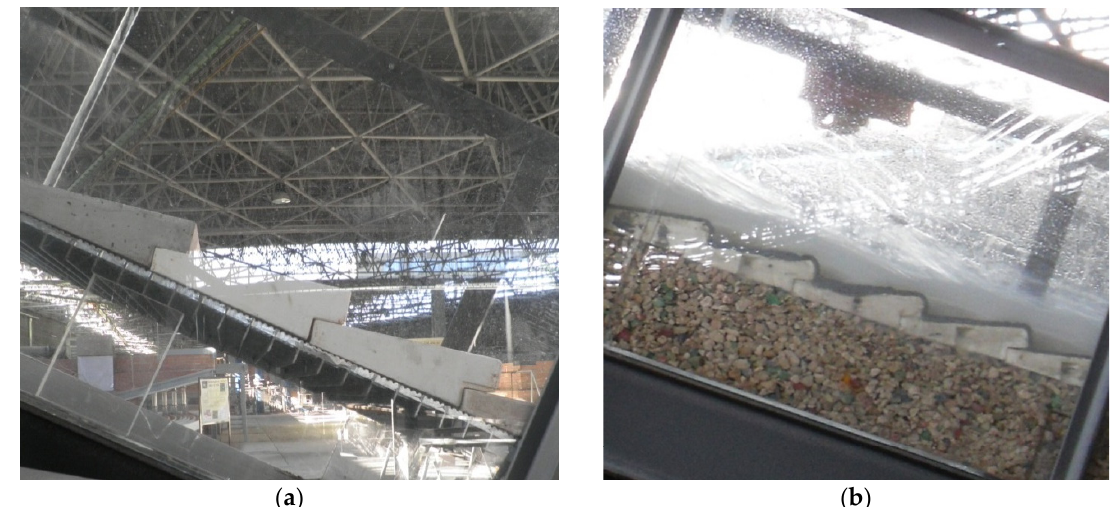
Figure 8. WSBs placed over ( a ) a non-slip metallic grid and ( b ) a granular drainage layer.